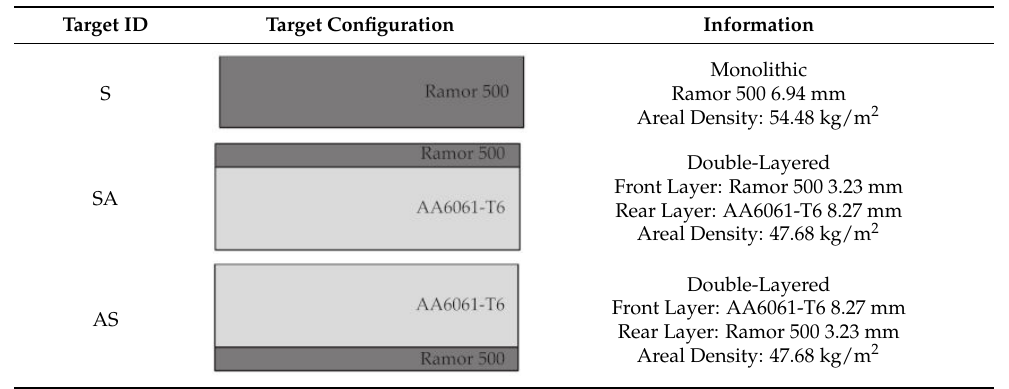
Table 2. High-velocity impact tests target configurations.